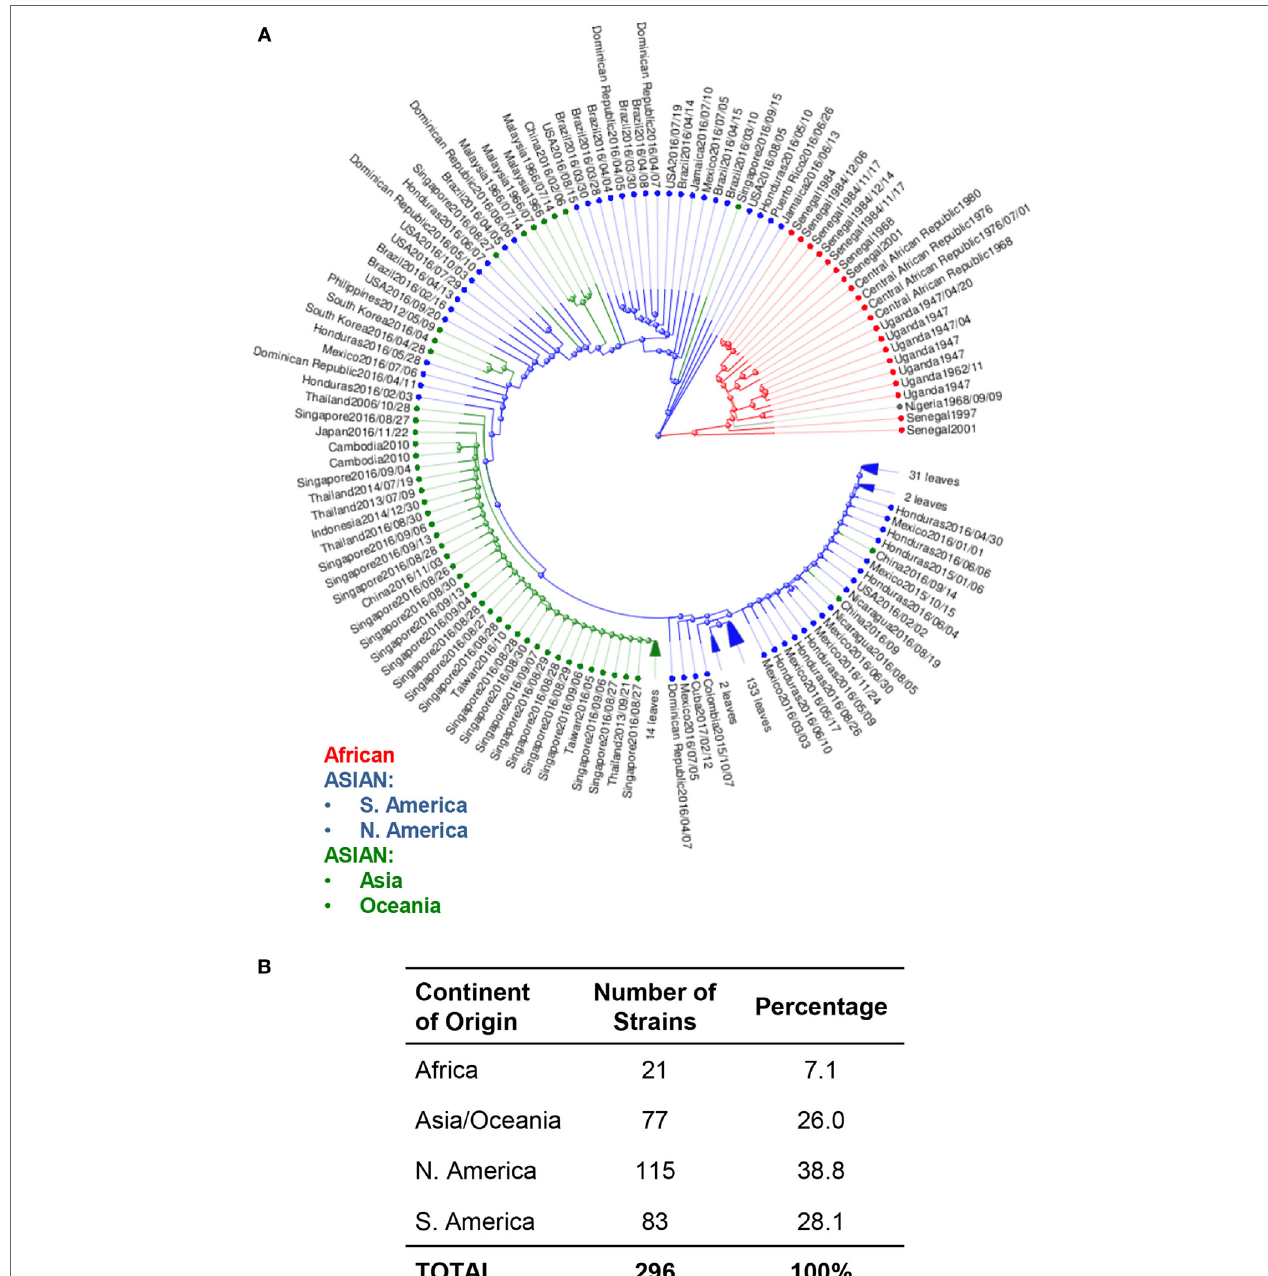
FiGURe 2 | Phylogenetic analysis of Zika virus (ZIKV) genomes by region. (A) Phylogenetic analysis of available ZIKV genomes was organized according to lineage, followed by continent of isolation using Virus Variation analysis system available through NCBI. Only complete nucleotide genomes were screened and duplicate strains were removed to produce 296 unique strains. Strains were clustered from Africa (red), from the Americas (Asian lineage) (blue); and from Asia and Oceania (Asian lineage) (green). (B) The total number of strains isolated per continent was used to derive the percentage of each host within the grand